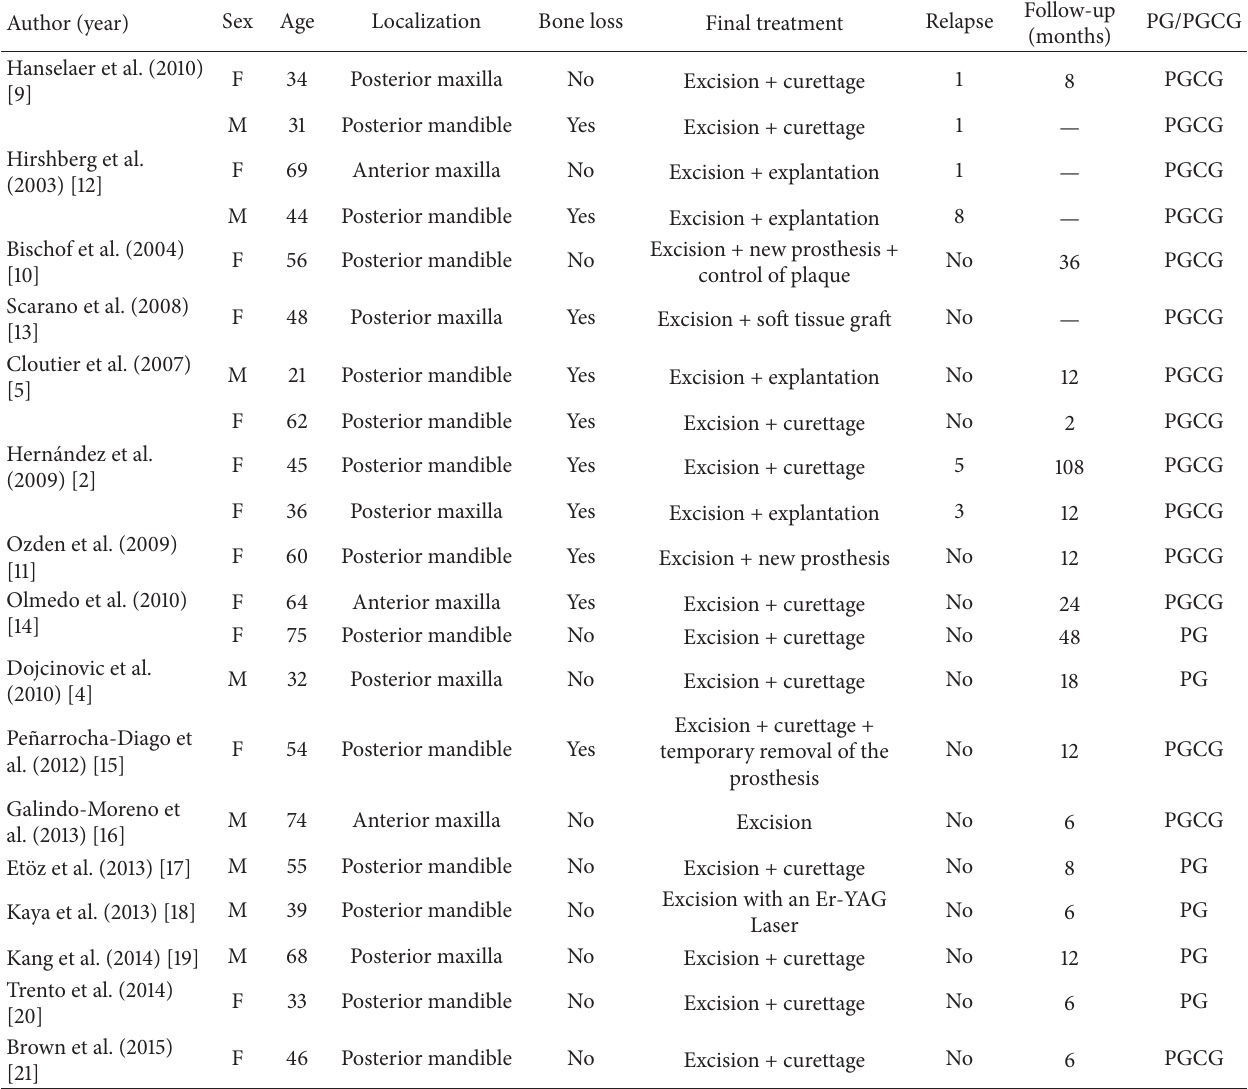
Table 2: Most highlighted characteristics from published cases of PG and PGCG associated with